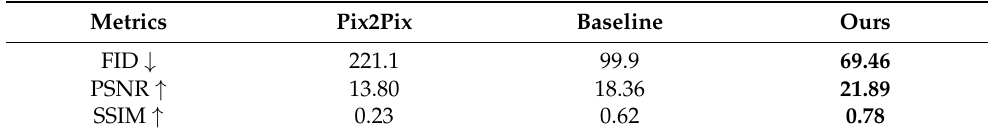
Table 2. Evaluation metrics comparison under a simple